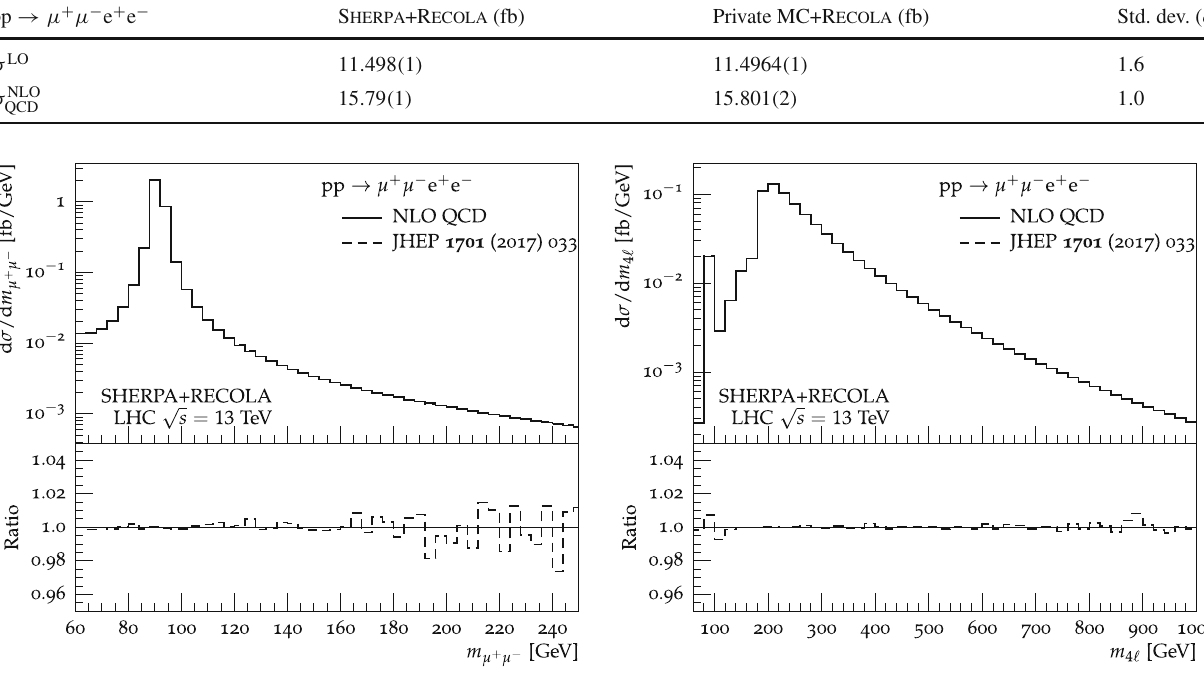
Table 4 Integrated cross sections calculated at μ + μ − e + e − at LO and NLO QCD with the Sherpa + Recola interface, compared against the independent private multi-channel Monte Carlo